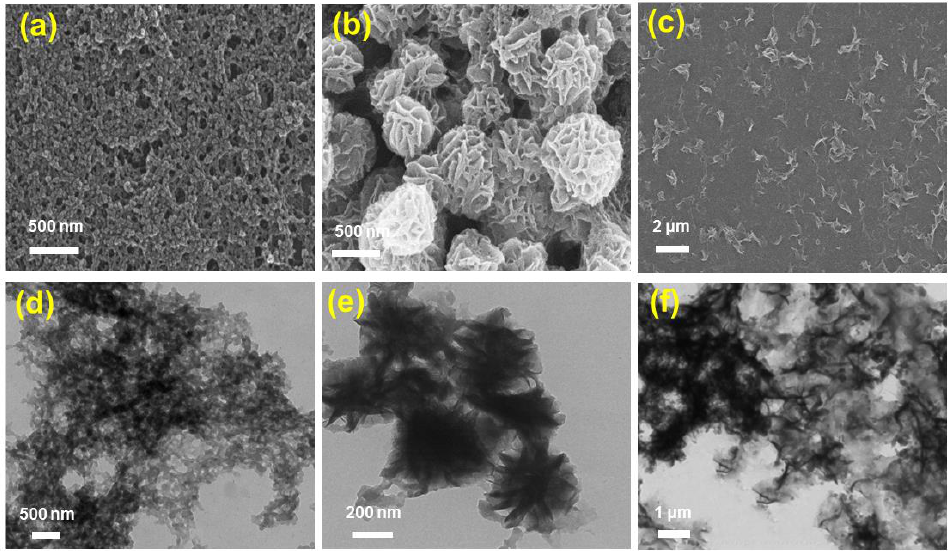
Figure 2. The SEM ( a – c ) and TEM ( d – f ) images of [Fe II -THPP-NPs] ( a , d ), [Co II -THPP-flower] ( b , e ), and [Co II -THPP-film] ( c , f ). Table 1. Crystal data and structure refinement parameters for Fe II -THPP.